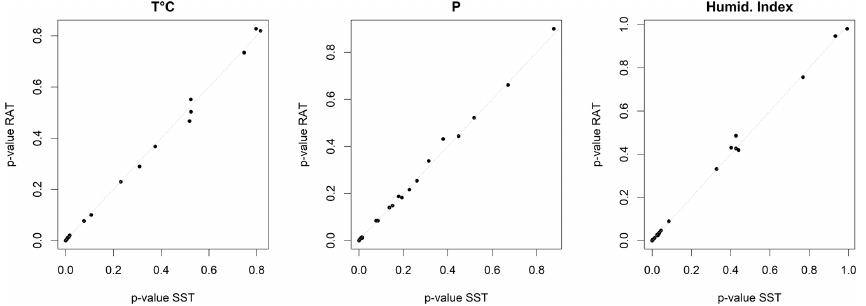
Figure A3. Spearman correlation p value from the correlation for annual bias and annual temperature, precipitation, and humidity index ( P/E 0 ). Comparison between RAT and SST (one point per catchment).